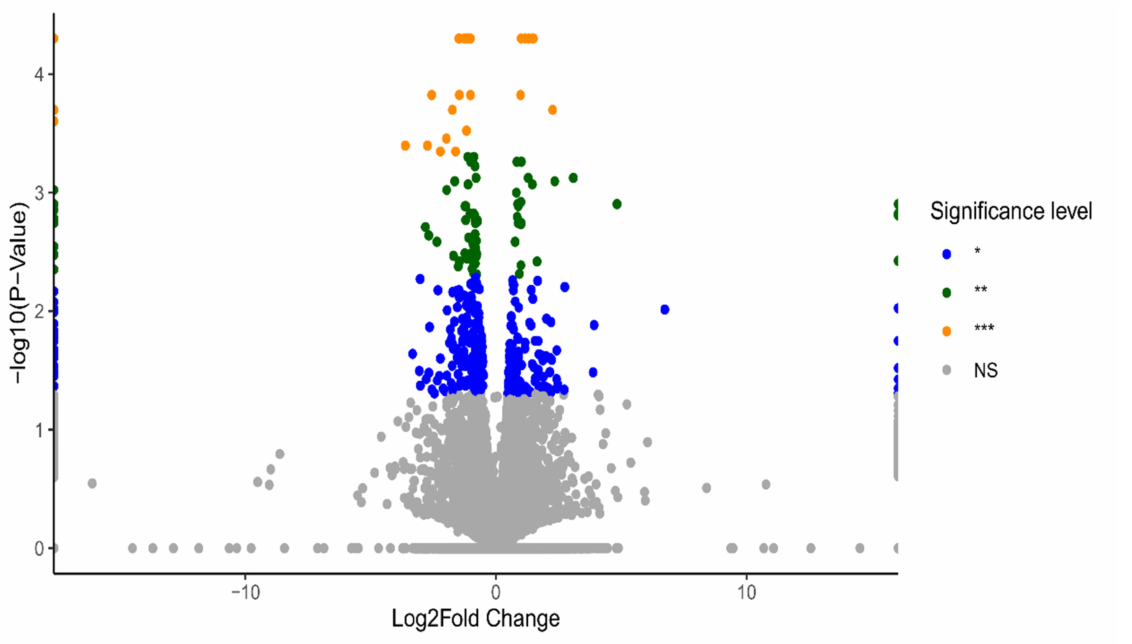
Figure 2. Volcano plot presenting the differentially expressed genes (DEGs) upon the treatment of BPA at 100 nM. Significance level for these gene was set as: blue dots * p -value < 0.05, green dots ** p -value < 0.005, orange dots *** p -value < 0.0005, and grey dots for no significant change (NS). In total, 272 DEGs were identified in 10 nM BPA-treated HOSEpiC samples and 454 DEGs in the 100 nM BPA-treated ones compared to the control group. Among the DEGs identified in both groups, 76 genes were found to be commonly dysregulated irrespective of the level of BPA exposure (Figure